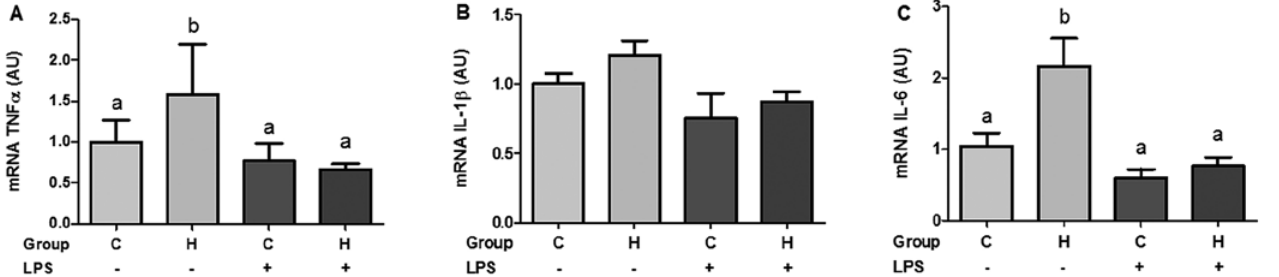
FIGURE 5 – Relative mRNA expressions of TNFα (A), IL-1b (B) and IL-6 (C) of peritoneal macrophages from mice fed the C or H diet for 6 week and incubated (+) or not (-) with LPS (1.25 pg/mL) for 2 h. (n =